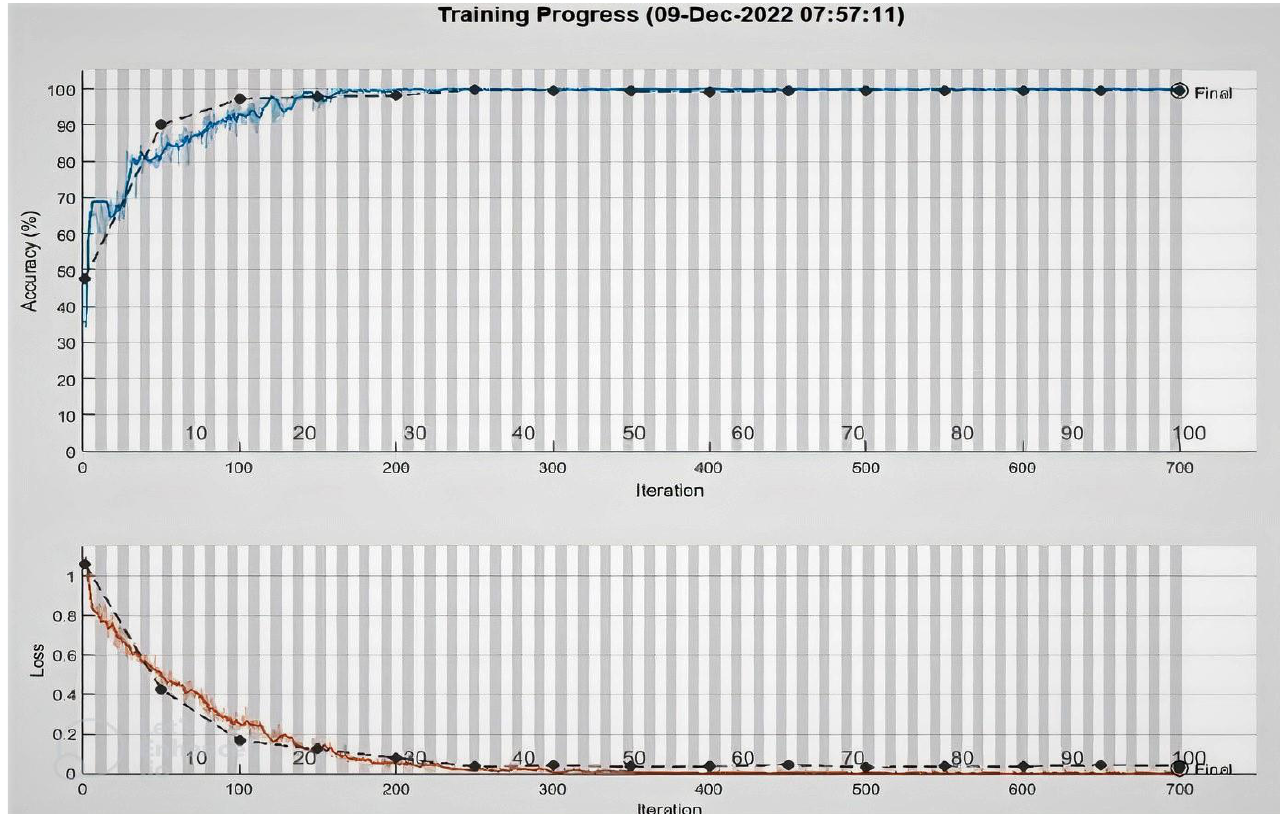
Figure 5. Accuracy and loss function graph of DeepBreastCancerNet.